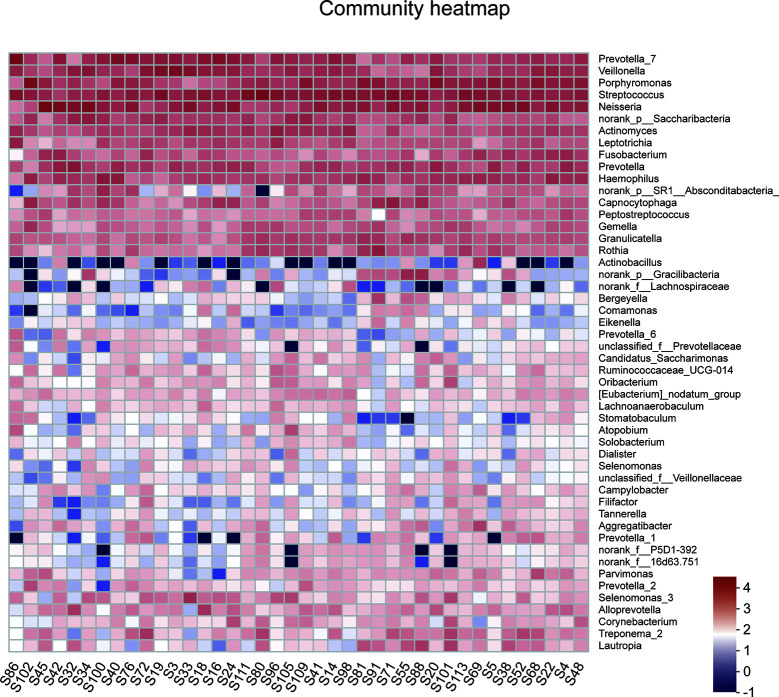
A heatmap of the abundance of top 50 abundant genera in each sample. The right side of the legend shows the color range of different R values. The color gradient of the color block was used to show the variation in abundance of different species in the sample.